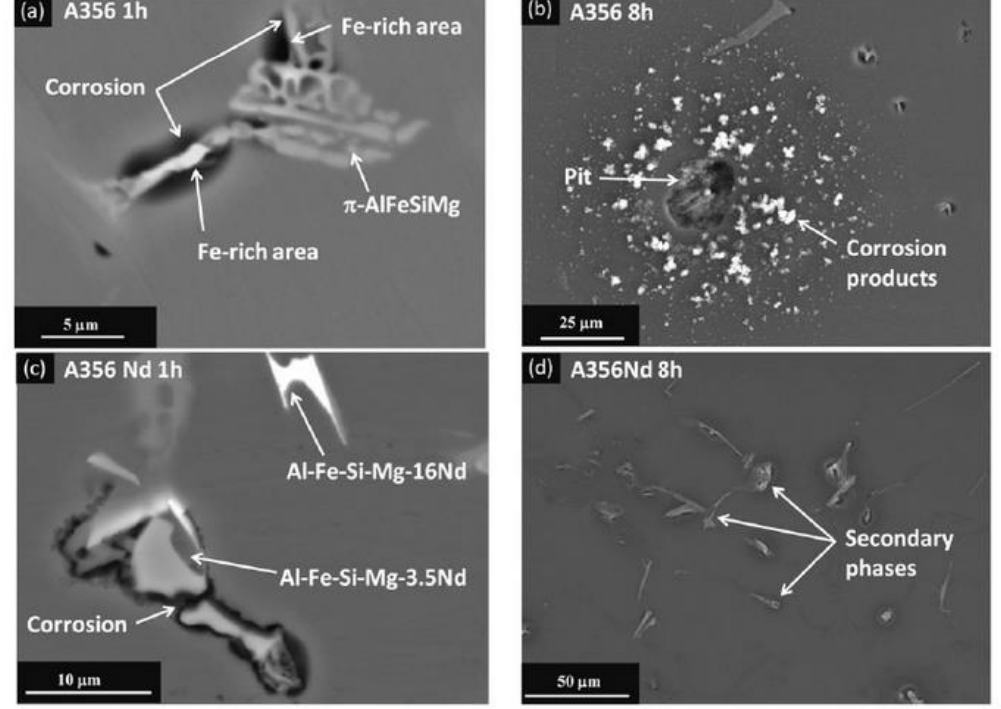
Figure 5. SEM micrographs of the initial stages of corrosion attack of A356 ( a , b ) and A356Nd ( c , d ) alloys as a function of time: ( a , c ) 1 h, ( b , d ) 8 h. Reprinted with permission of [9].